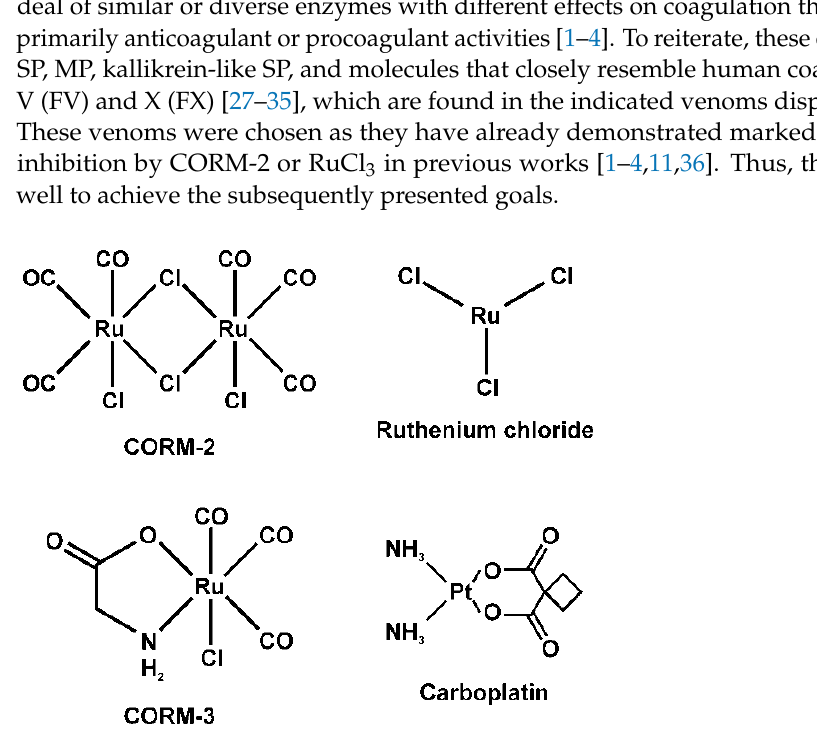
Figure 1. The structures and names of the Ru-based and platinum (Pt)-based compounds used in the present